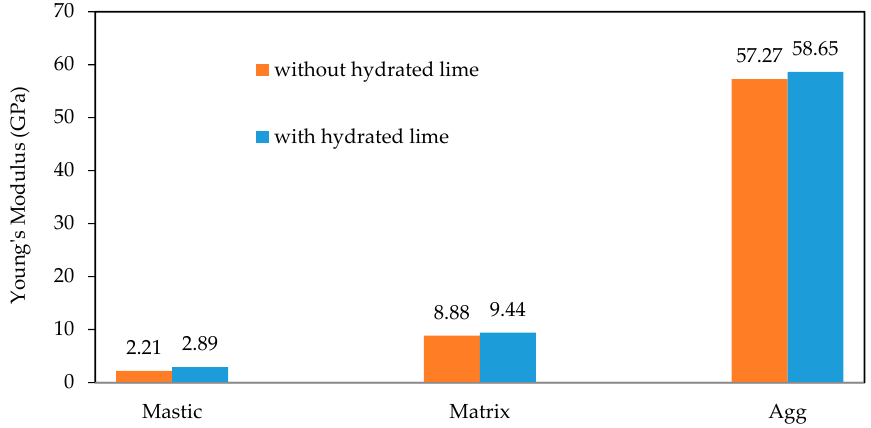
Figure 14. Average Young’s modulus values obtained from the indentation grids .